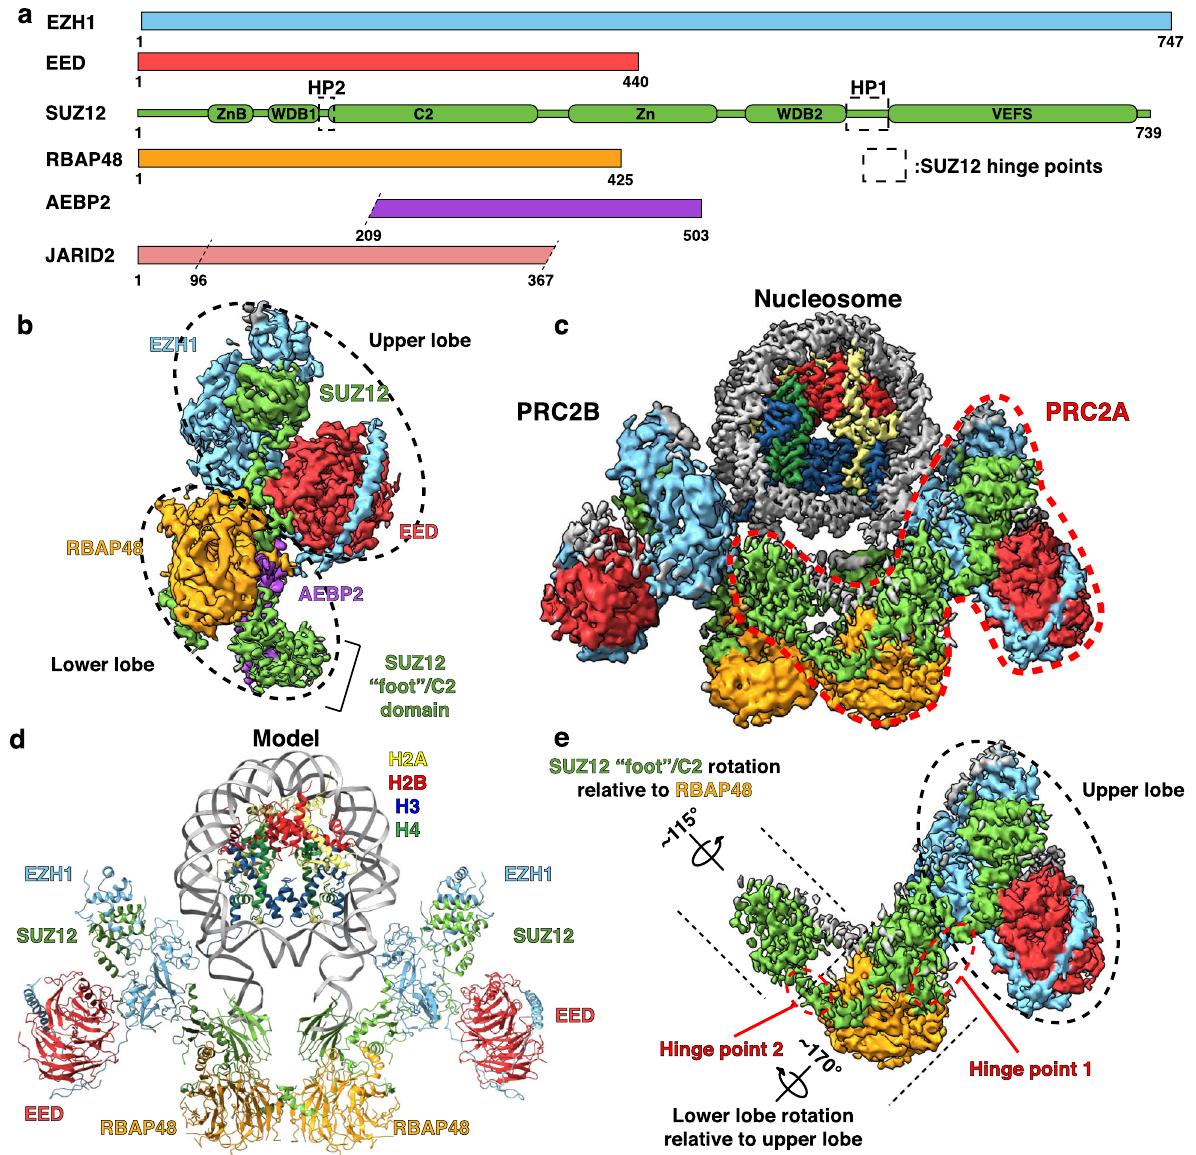
Fig. 1 Structures of monomeric and dimeric PRC2:EZH1. a Cartoon representation of the proteins used to generate PRC2:EZH1 complexes. Hinge points (HP) 1 (aa 535 – 561) and 2 (aa 146 – 155) are regions in SUZ12 that appear to allow the upper and lower lobes to rotate with respect to each other and the C2 domain to rotate with respect to RBAP48. JARID2 amino acids 96 – 367 were used in the monomeric PRC2 complex, while amino acids 1 – 367 were used in the PRC2 – nucleosome complex. b Cryo-EM map of monomeric PRC2:EZH1 showing the upper and lower lobes, and the SUZ12 ” foot ” /C2 domain. Colors are as in panel a . c Composite cryo-EM map of a PRC2:EZH1 dimer bound to a nucleosome containing the H3K27M and H2AUb modi fi cations. Protein subunits are colored as in panel a . One unit of the PRC2 dimer “ PRC2A ” is outlined with a dashed line. d Model of the PRC2:EZH1 dimer bound to a nucleosome containing the H3K27M and H2AUb modi fi cations with subunits labeled. The model was built using the composite map except for nucleosomal DNA, which was modeled based on the 7-Å resolution map. e Cryo-EM map of a single PRC2:EZH1 monomer from the structure of the nucleosome-bound PRC2:EZH1 dimer. Compare to map of monomeric PRC2:EZH1 in panel b . Note that the lower lobe rotates ~170° relative to the upper lobe, and the C2 domain rotates ~115° relative to